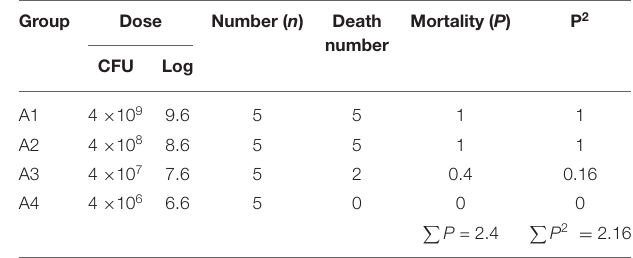
TABLE 7 | Experimental data on pathogenicity in